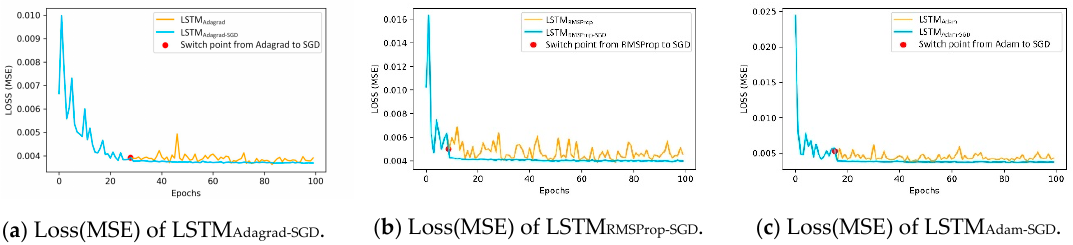
Figure 13. Loss (MSE) of the LSTM Adagrad-SGD , the LSTM RMSProp-SGD and the LSTM Adam-SGD models compared with the LSTM model with a single optimization algorithm.